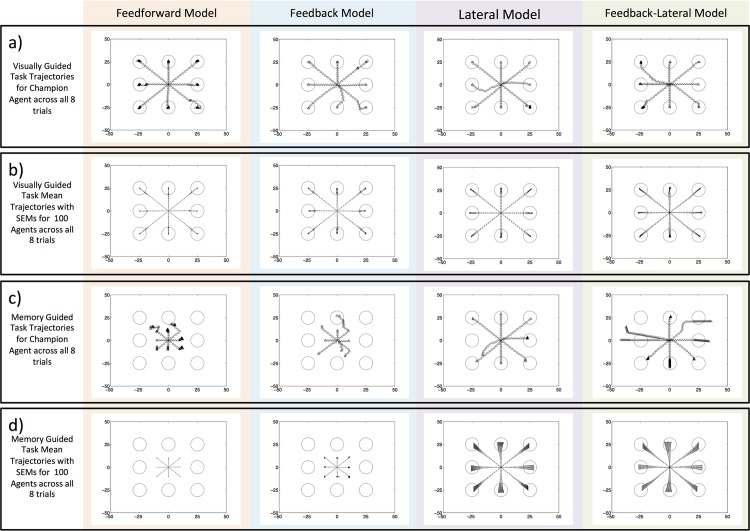
Reaching Trajectories.All plots show the reaching trajectories across all 8 trials with each point representing the hand position at a timestep in 2-D Euclidian space mapped in degrees of visual angle. The circles are centered on the target locations for the 8 trials. The x and y-axes are labeled in degrees of visual angle ranging from [–50, 50] in both the horizontal and vertical directions. The columns represent the data from the four models (from left to right: FF, FB, LAT, and FBLAT). a) The champion agents’ reaching trajectories for the VG task. b) The means and standard error of the means (SEMs) for reaching trajectories at each timestep from the 100 independently evolved best agents (including the champion agent) for the VG task. c) The champion agents’ reaching trajectories for the MG task. d) The population means and SEMs for reaching trajectories at each timestep from the 100 independently evolved best agents (including the champion agent) for the MG task. In a and b, all four models’ performed well on the VG task. In c and d, only the LAT and FBLAT models performed well in the MG task.